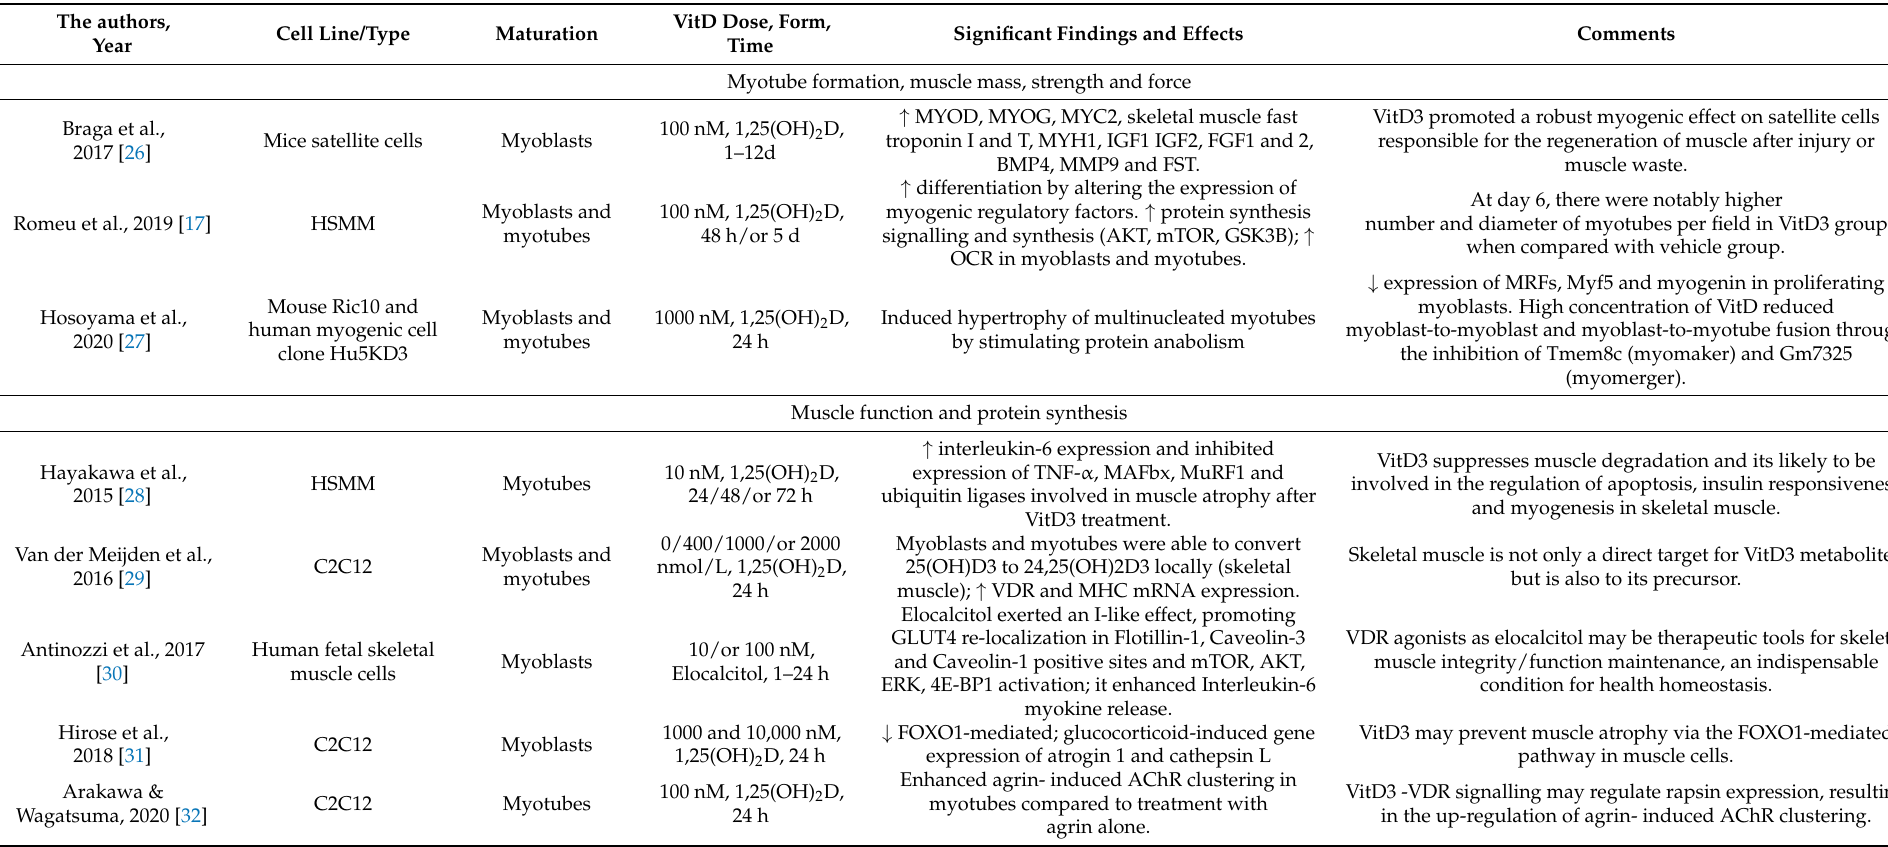
Table 1. Overview of the effects of vitamin D (VitD) in skeletal muscle cells ( n = 18 in vitro studies) stratified by